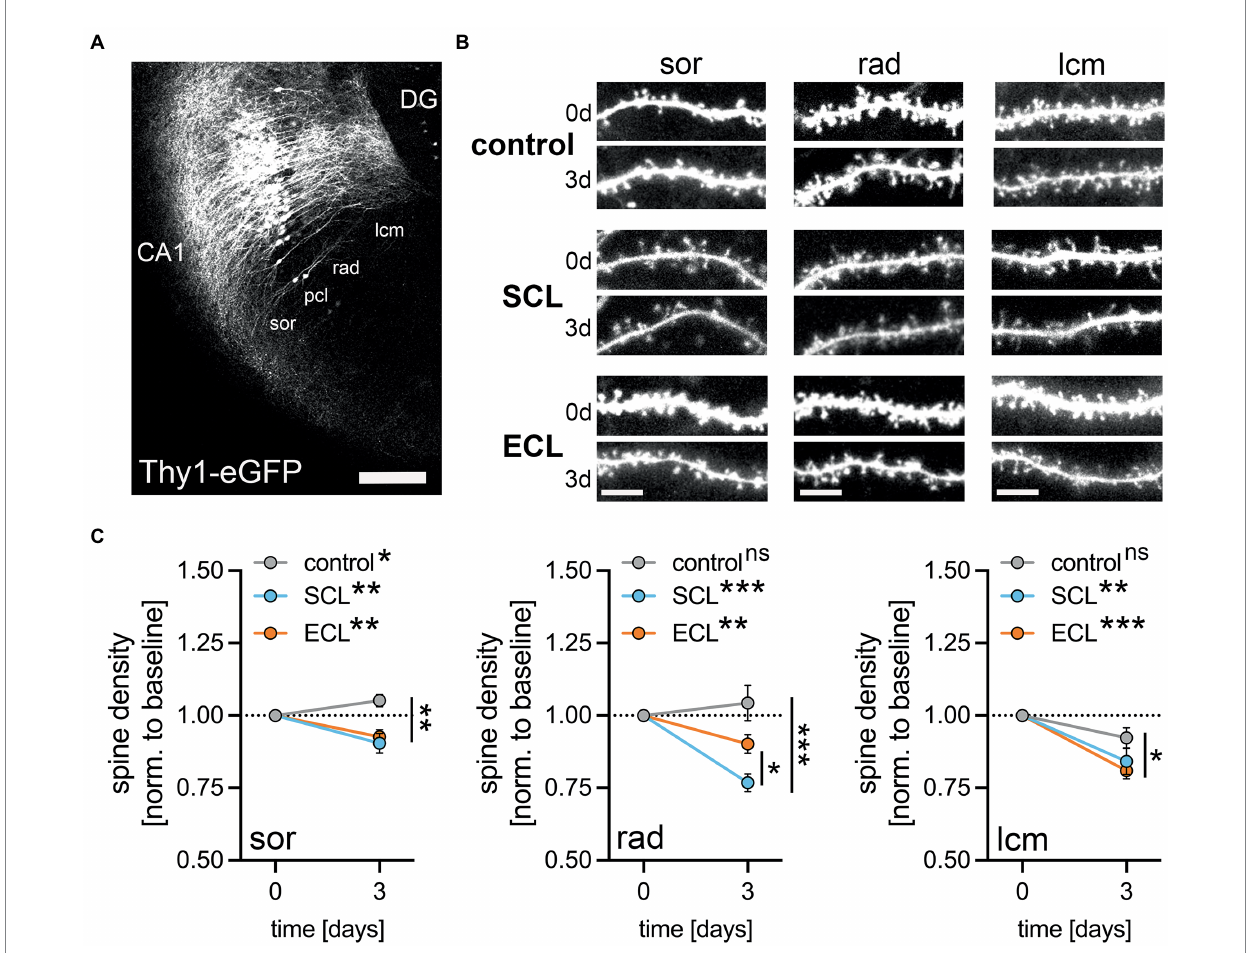
FIGURE 3 Lesion is accompanied by a loss of dendritic spines in CA1 pyramidal neurons. (A) CA1 region of an entorhino-hippocampal tissue culture from Thy1- eGFP mice (DG, dentate gyrus; sor, str. oriens; pcl, str. pyramidale; rad, str. radiatum; lcm, str. lacunosum-moleculare). Scale bar, 200 μ m. (B) Layer- specific time-lapse images of CA1 dendrites at day 0 (0d) and day 3 (3d) following SCL or ECL, respectively. Scale bar, 5 μ m. (C) Both SCL and ECL lead to a significant, yet layer-unspecific, decrease in spine density in hippocampal CA1 neurons. However, the magnitude of spine loss in rad showed significant differences between the lesions, where SCL caused a more prominent reduction than ECL ( p = 0.02; sor: n control = 37 dendritic segments, n SCL = 24 dendritic segments, n ECL = 34 dendritic segments, rad: n control = 23 dendritic segments, n SCL = 29 dendritic segments, n ECL = 21 dendritic segments, lcm: n control = 15 dendritic segments, n SCL = 11 dendritic segments, n ECL = 20 dendritic segments, Wilcoxon matched-pair signed rank test for time- dependent changes and Kruskal-Wallis test followed by Dunn’s posthoc correction for endpoint comparisons). Values represent mean ± s.e.m. (* p <